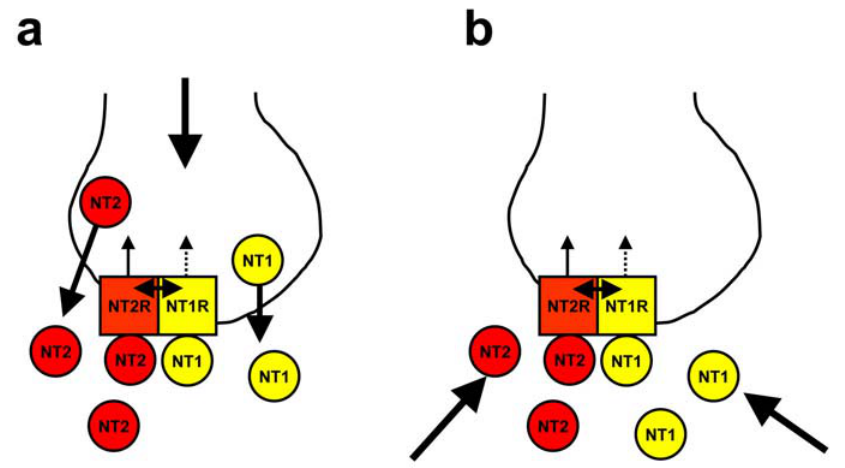
FIGURE 2. Heteromers of receptors for different neurotransmitters. (a) Neurotransmitter corelease. The different units of the receptor heteromer (NT1R and NT2R), which is localized in the synaptic or perisynaptic space, are activated by different neurotransmitters (NT1 and NT2) that are coreleased in the same synapse; the signaling depends on the intermolecular cross-talk. (b) Volume transmission. The different units of the receptor heteromer (NT1R and NT2R), which are localized extrasynaptically, are activated by different neurotransmitters released by different cells (NT1 and NT2) that reach the heteromer by volume transmission; the signaling depends on the intermolecular